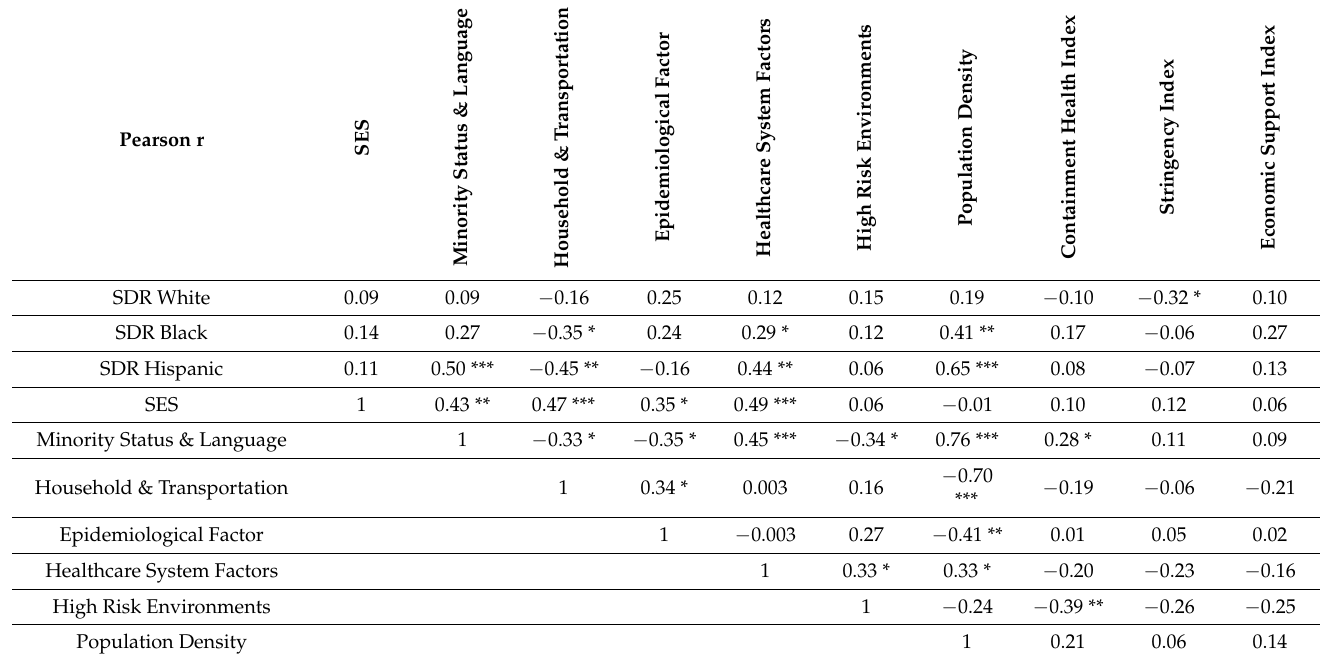
Table 3. Correlation matrix of the seven categories of the CCVI, the three sub-indices of the OxCGRT and the SDR for each group.